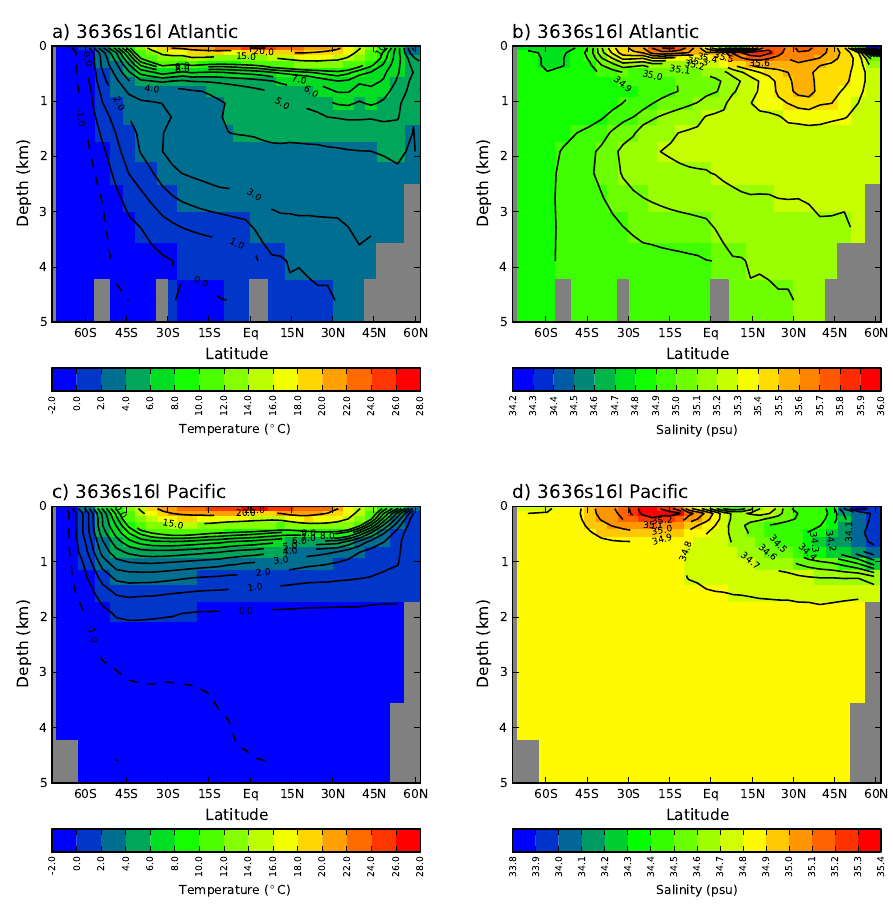
Fig. 11. Zonally-averaged meridional sections of annual-mean temperature and salinity in the Atlantic (a, b) and Pacific (c, d) .